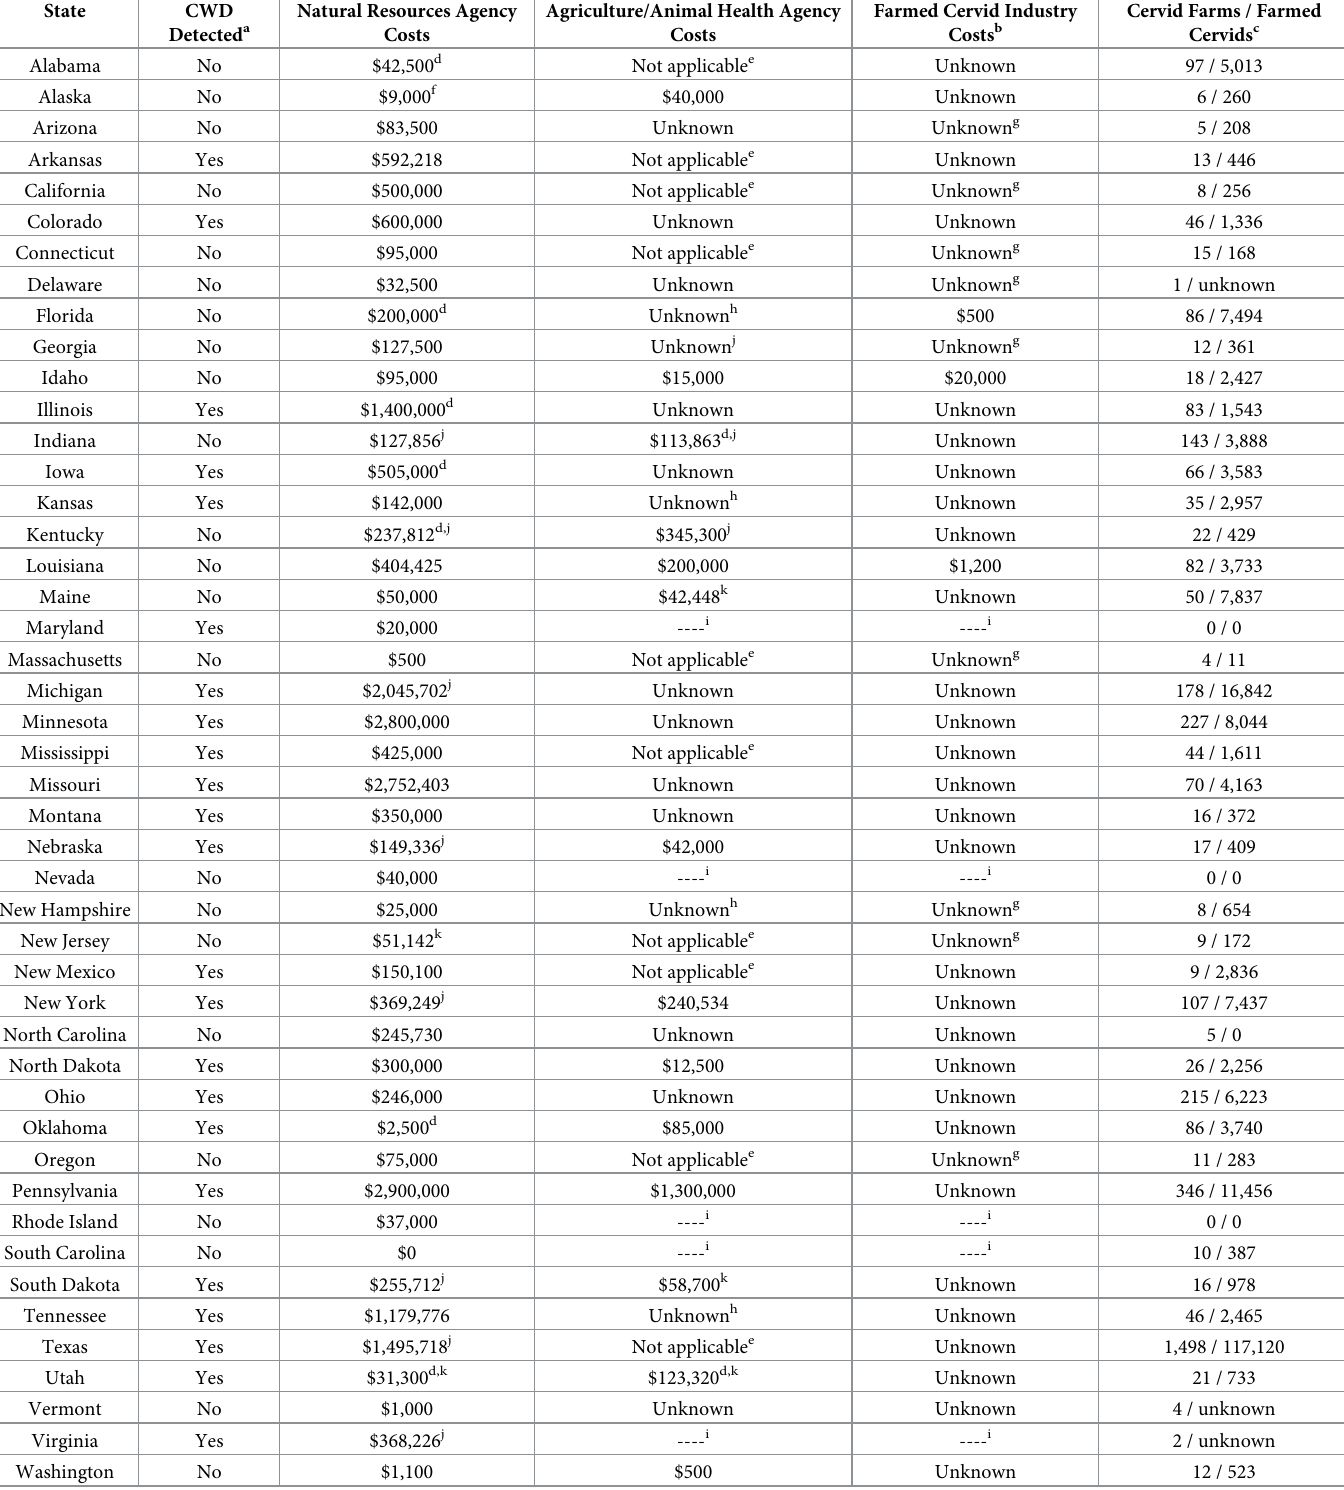
Table 1. Direct costs related to chronic wasting disease paid by state agencies and cervid farmers in the continental United States in 2020